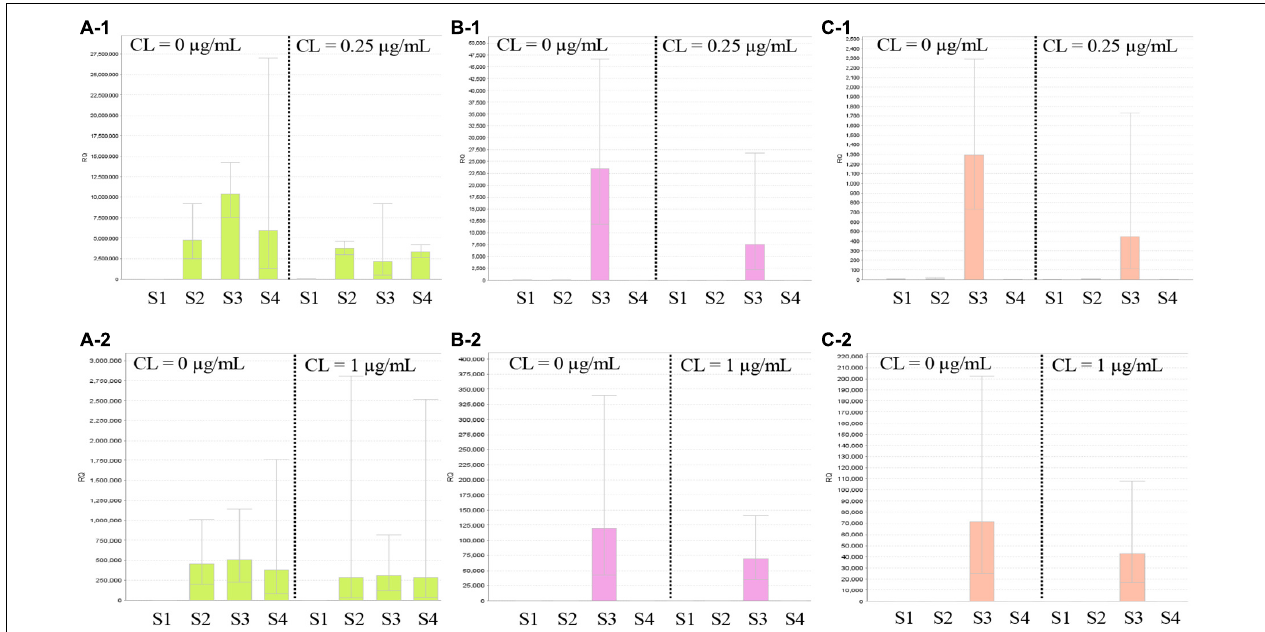
FIGURE 5 | Results of RT-qPCR of mcr-9 and qseB/C genes using three isolates with mcr-9 and E. coli ATCC25922. S1, E. coli ATCC25922 without mcr-9 and qseB/C ; S2, K. pneumoniae THUN262 with mcr-9 ; S3, E. kobei THUN627 with mcr-9 and qseB/C ; and S4, E. coli THUN648 with mcr-9 . (A-1) RT-qPCR of mcr-9 cultured for 4 h and (A-2) for 24 h. (B-1) RT-qPCR of qseB cultured for 4 h and (B-2) for 24 h. (C-1) RT-qPCR of qseC cultured for 4 h and (C-2) for 24 h. Each assay was performed in duplicate. Quantitative values were calculated by relative quantitative PCR using E. coli ATCC25922 as the reference for the Relative Quantification